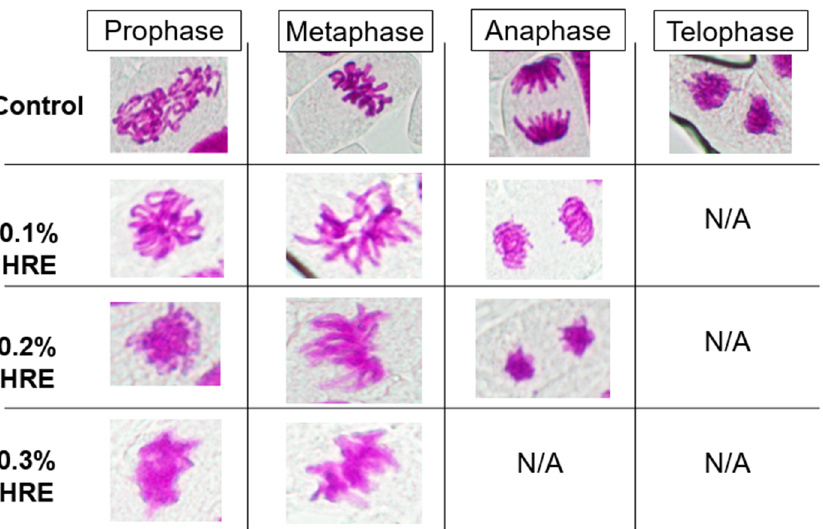
Figure 3. Representative images of mitotic stages after the treatment of the onion root tip with var- ious concentrations HRE. Onion root tips were dyed to observe the chromosomal status of each cell at HRE concentrations of 0% (control) and 0.1%, 0.2%, and 0.3%. We distinguished the mitotic stages of the cells into prophase, metaphase, anaphase, and telophase. N/A means not applicable. HRE, horseradish extract.